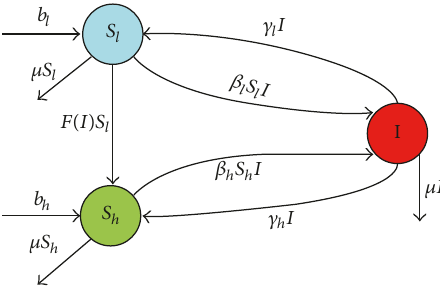
Figure 2: Transition diagram of the new